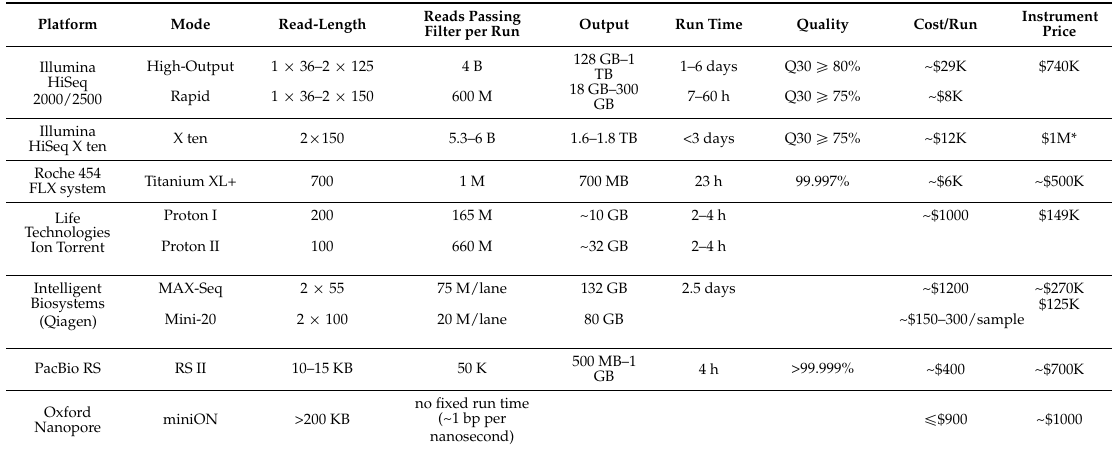
Table 2. Comparison of current common NGS